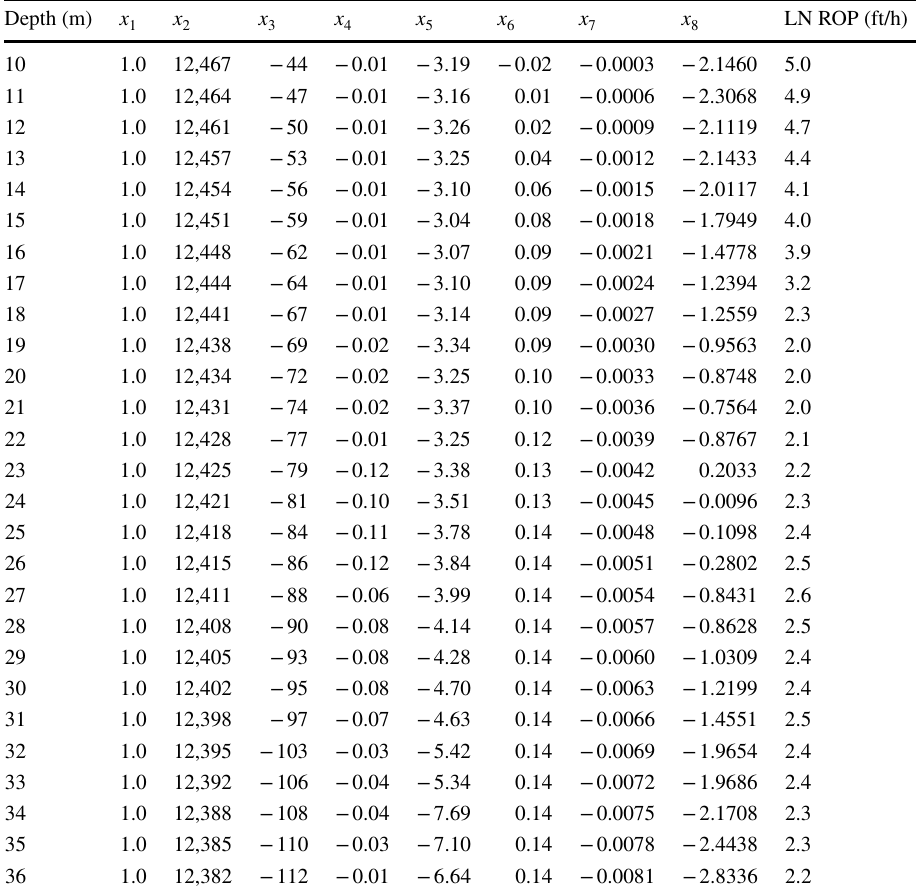
Table 8 Parameter